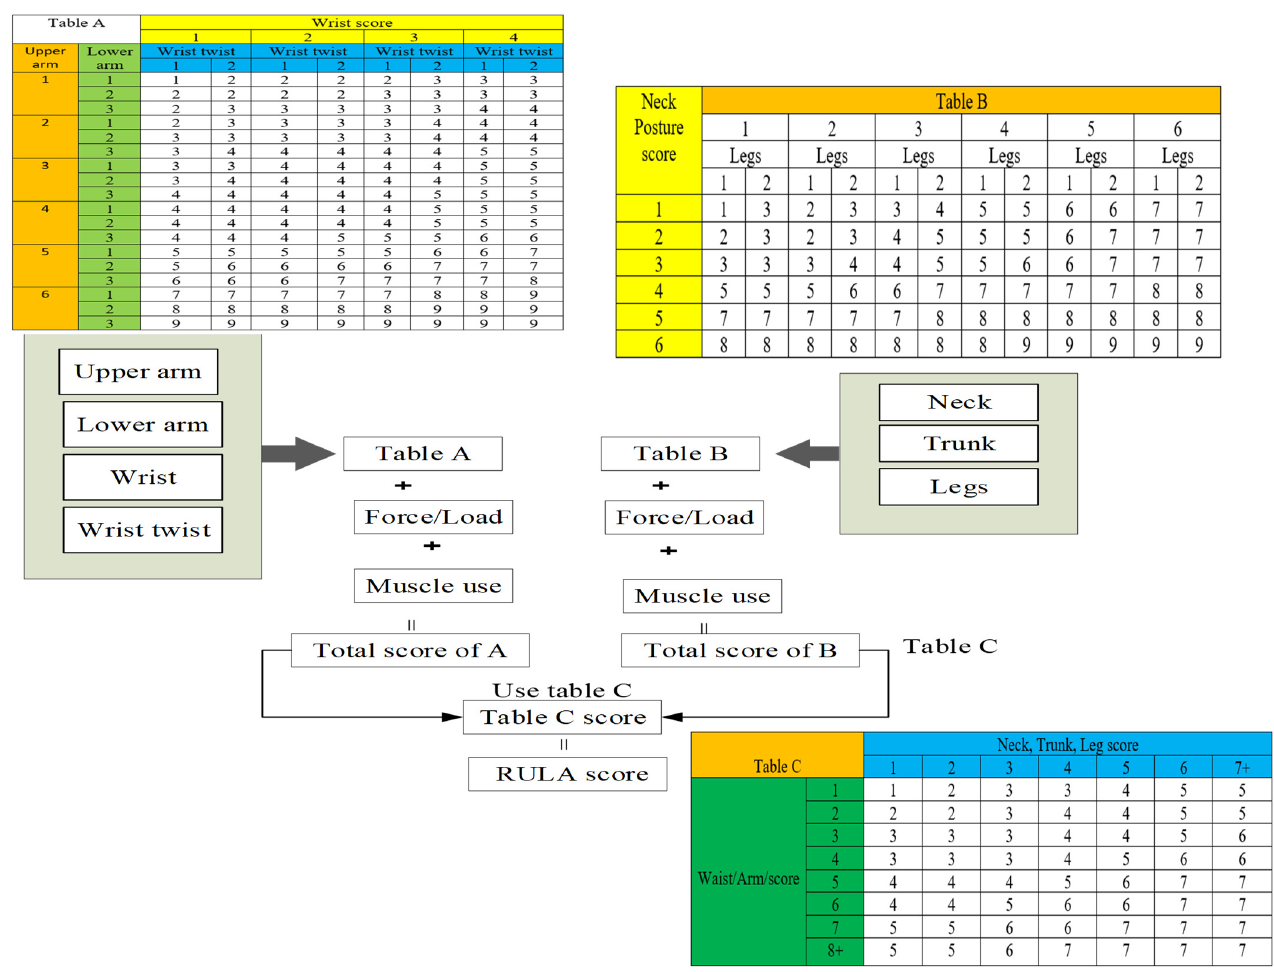
Figure 7. Standard scoring sheet for RULA.